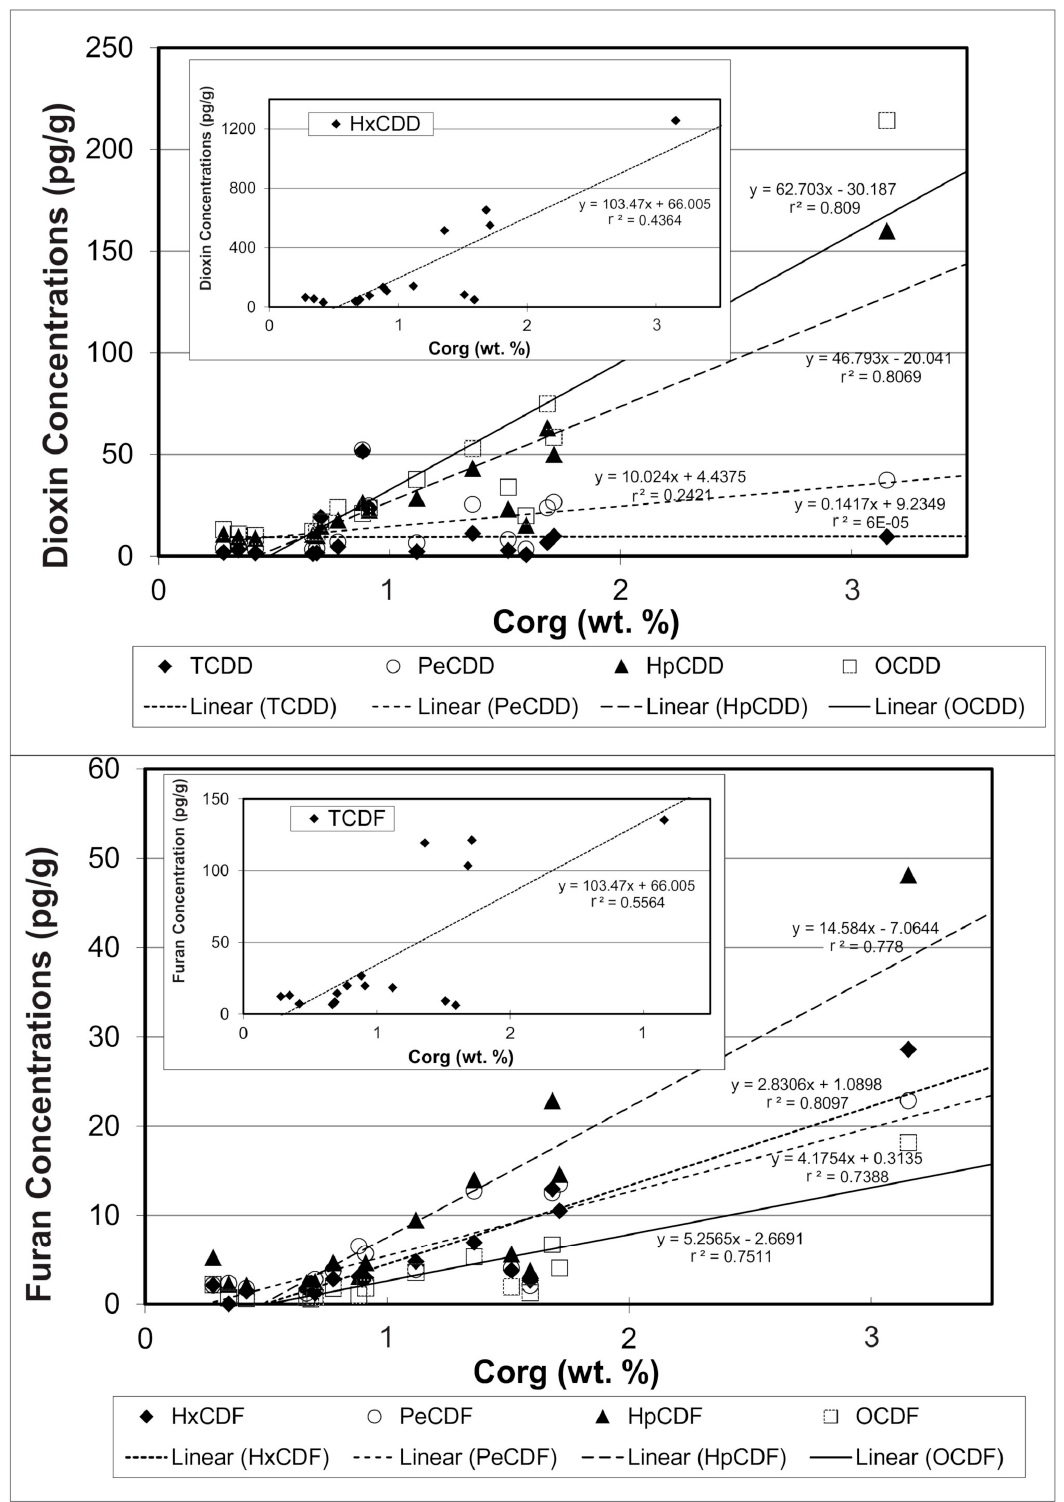
Figure 19. Plot of dioxin and Furan concentration versus organic matter concentration with the >63 µm fraction removed. Note the increase in r 2 value for HxCDD through OCDD dioxin and the decrease in r 2 value for TCDD and PeCDD.